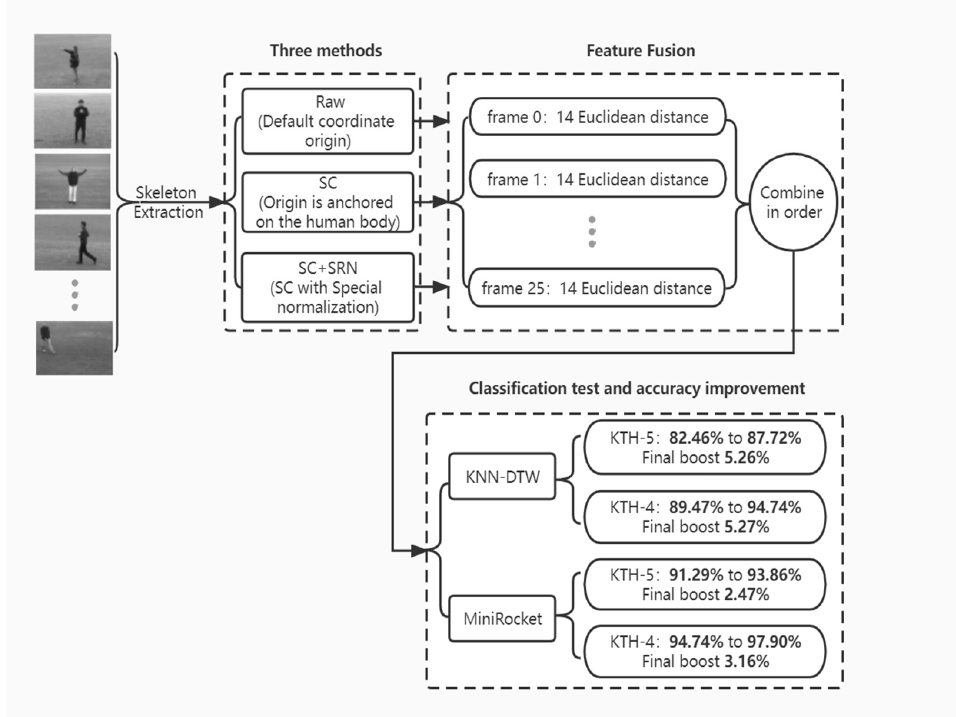
Figure 1. Flow chart for the experimental method. The proposed approach consists of three main components: handling, feature fusion, and classification testing. In addition, the accuracy improvement in the method for the classification tests is also listed.